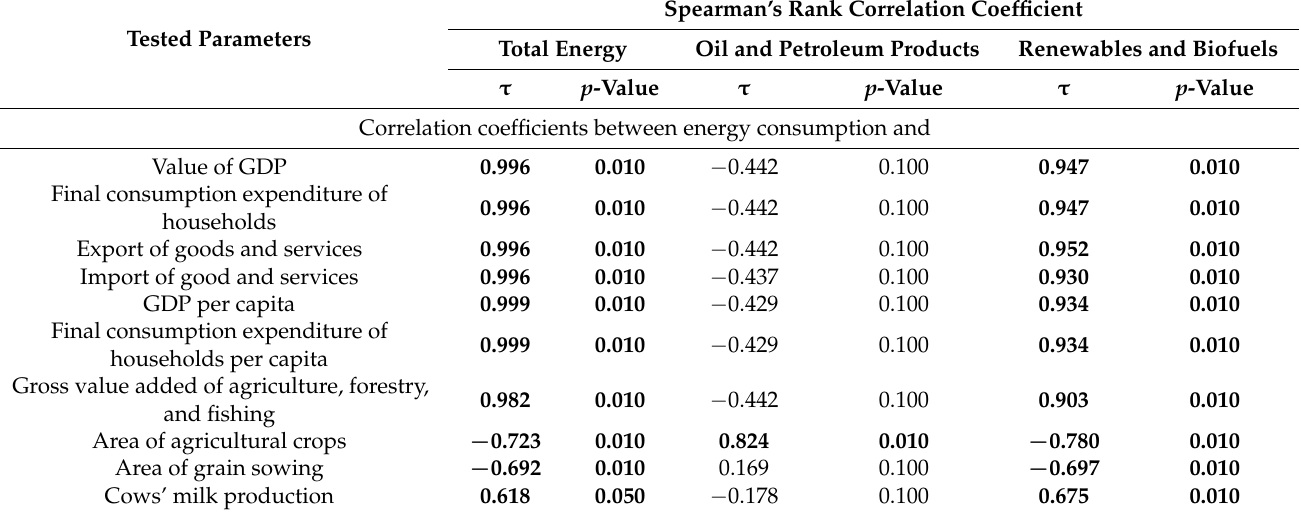
Table 5. Spearman’s rank correlation coefficients between the volume of use of energy in agriculture in the EU countries and the parameters of the economy and